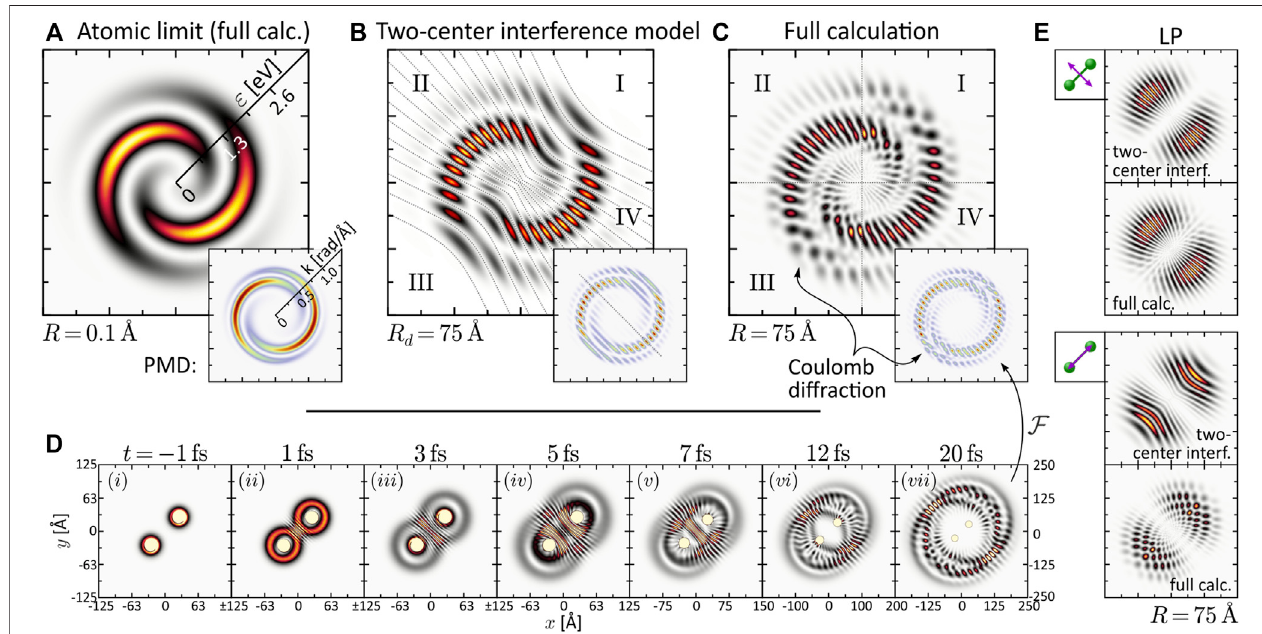
FIGURE 3 | (Color online.) Discussion of interference mechanisms on the example of the two-armed FEV created by one-photon ionization with an LRCP pulse sequence (cf. Panel 2 ). The two pulses are centered at τ 1 = − τ 2 = − 2 fs. (A) Energy-calibrated PMD of the FEV in the atomic limit R = 0.1 Å. The inset shows the actual PMD in momentum representation. (B) Two-center interference model based on the superposition of two atomic partial wave packets with origins displaced by R d = 75 Å. (C) Full calculation of the two-armed FEV in the dissociation limit R = 75 Å. (D) Time series of the electron density | ψ ( r ; R , t )| 2 illustrating the diffraction of the partial wave packets emitted from one nucleus at the Coulomb potential of the neighboring nucleus. (E) Comparison between two-center interference model and full calculation for the LP single-pulse scenarios orthogonal and parallel to the internuclear axis.